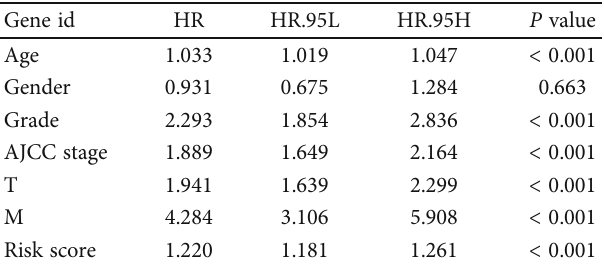
Table 4: The univariate Cox analysis of clinicopathological parameters and prognosis-related prediction model with the OS in ccRCC